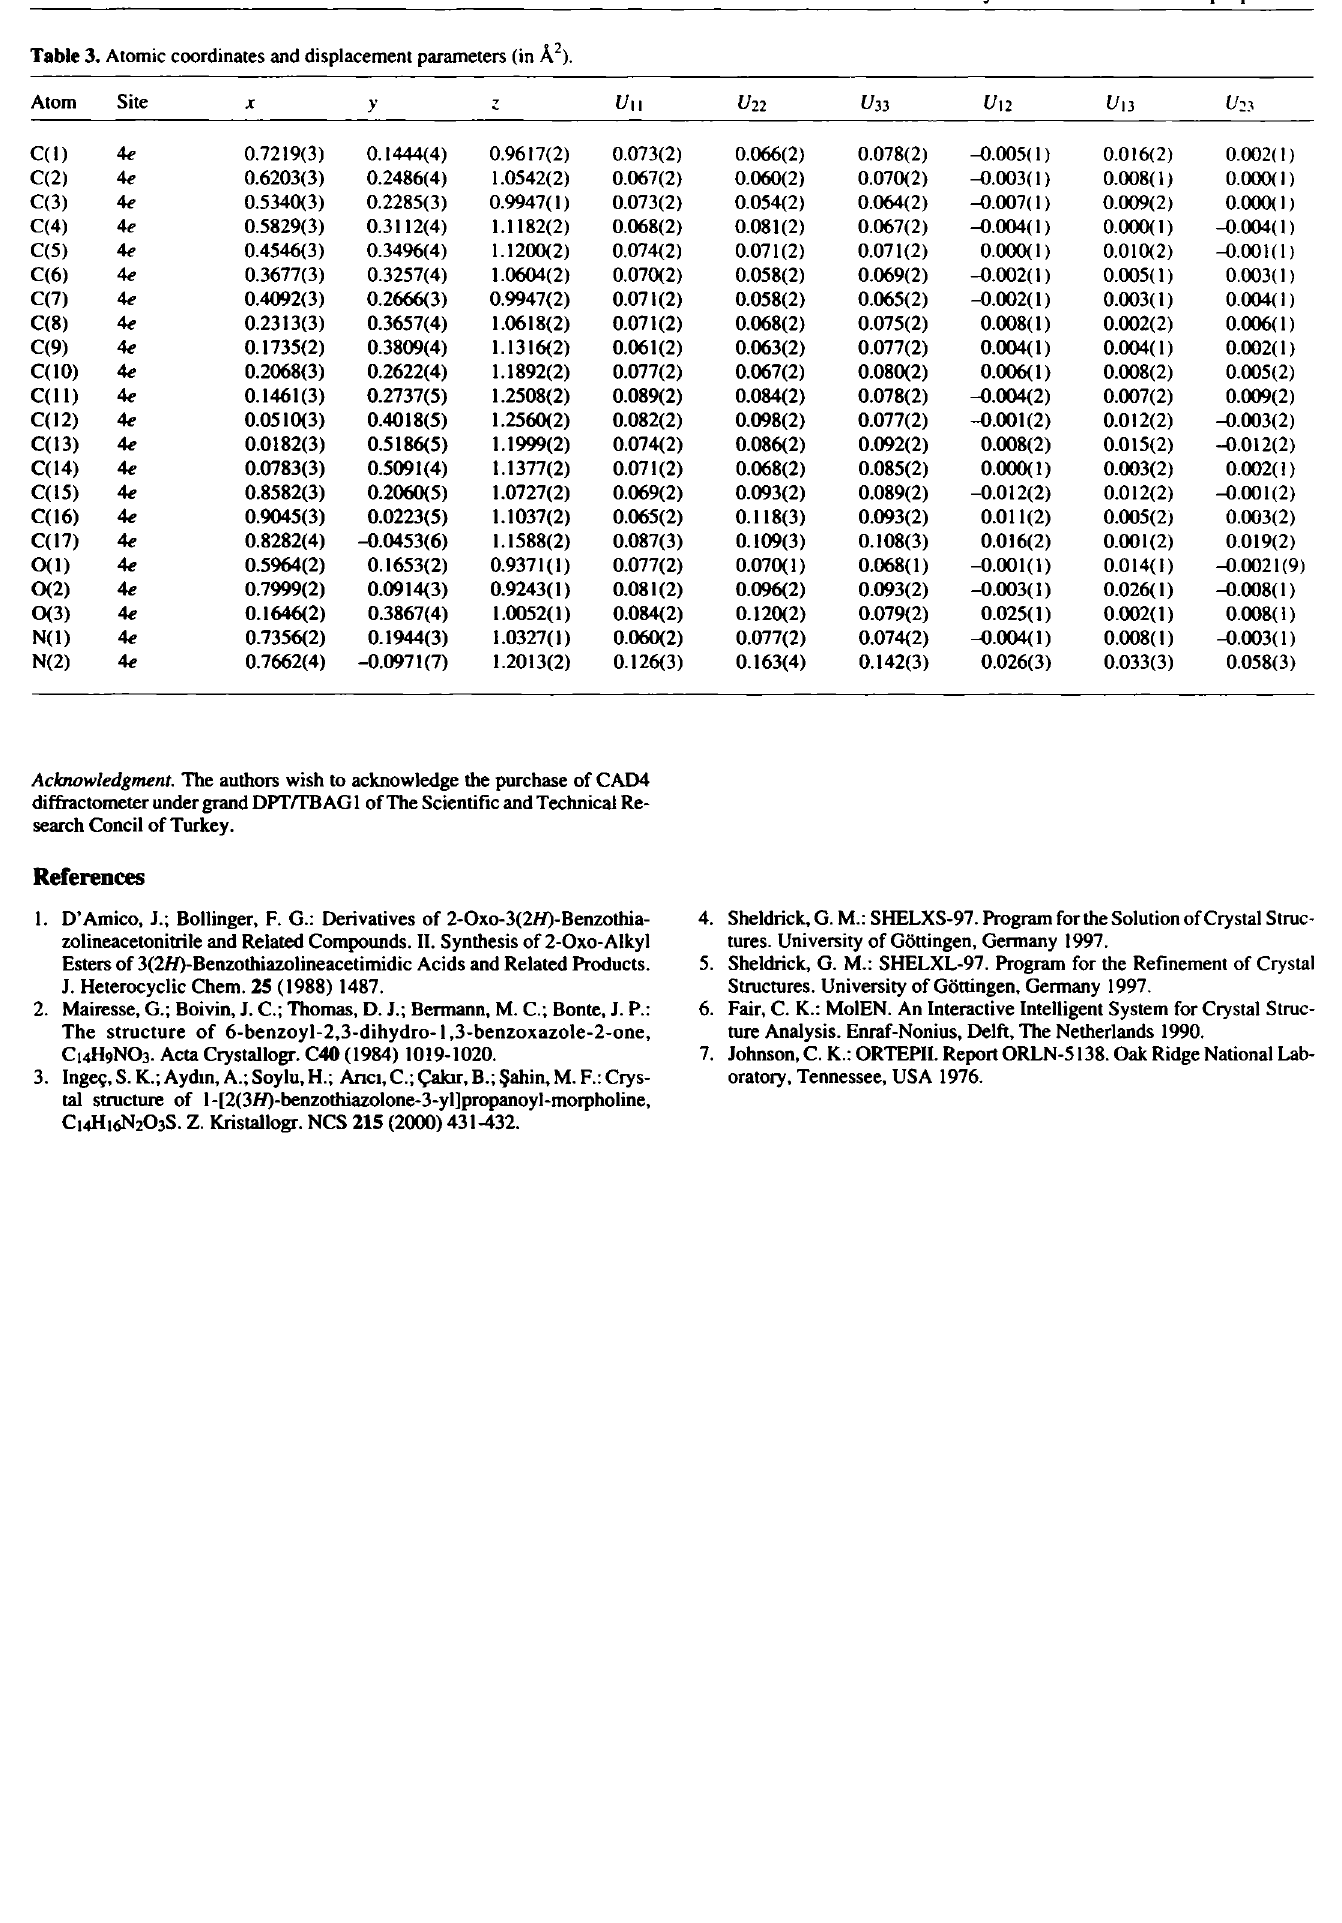
Table 3. Atomic coordinates and displacement parameters (in Ä 2